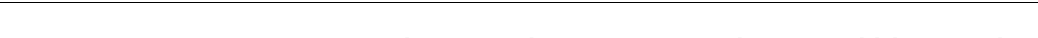
Table 3. Truckload and MPG by Farm Size and Vehicle Type Assumed in the Sensitivity Analysis Scenario